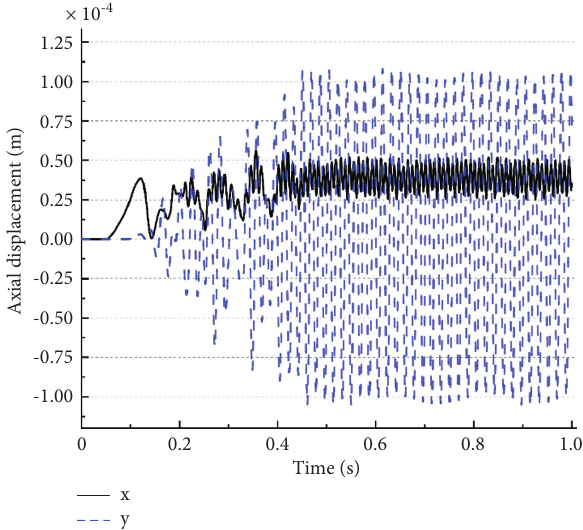
Figure 28: X- and Y -axis vibration displacement time-domain curves.